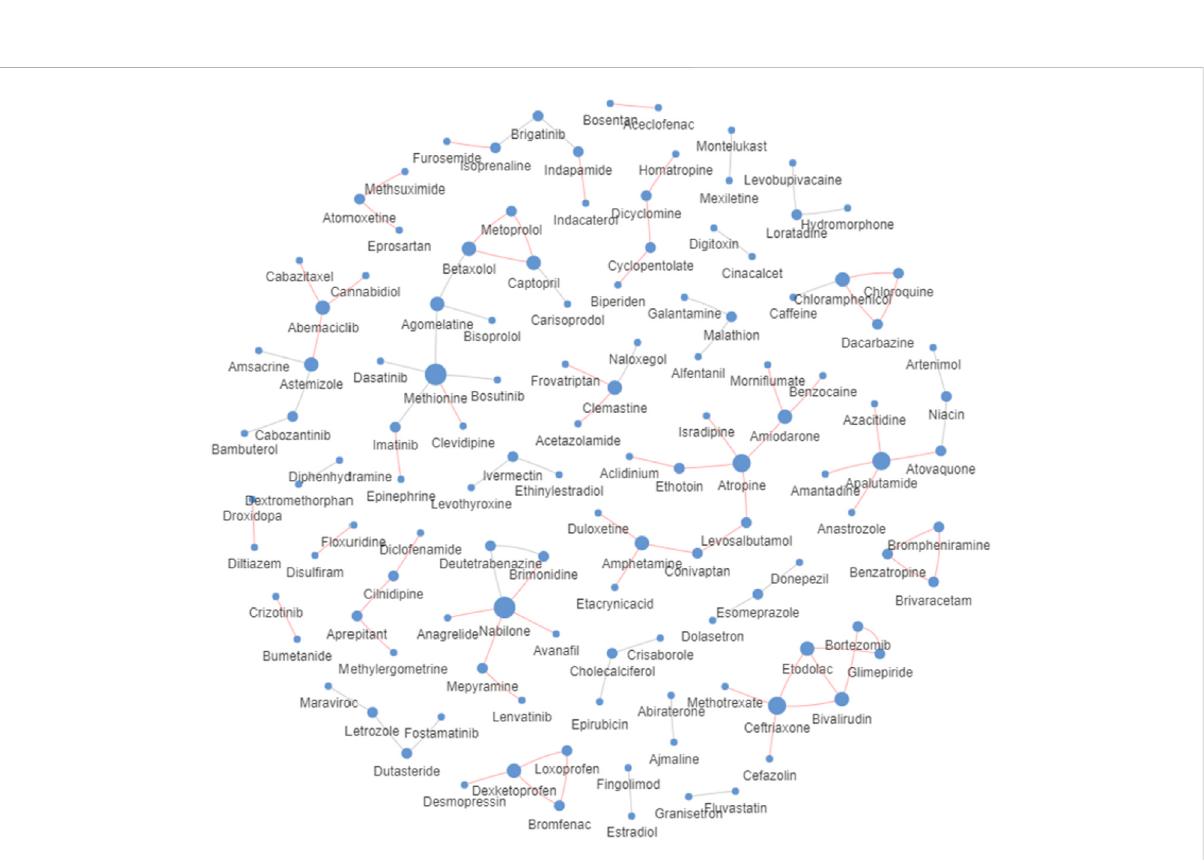
FIGURE 7 Validation of the predicted results for the top 100 drug